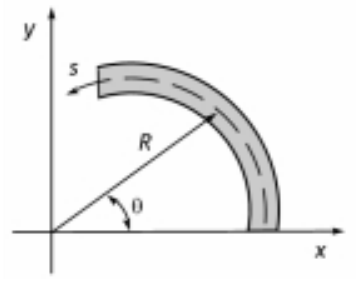
Fig. 1. Scheme of a circular